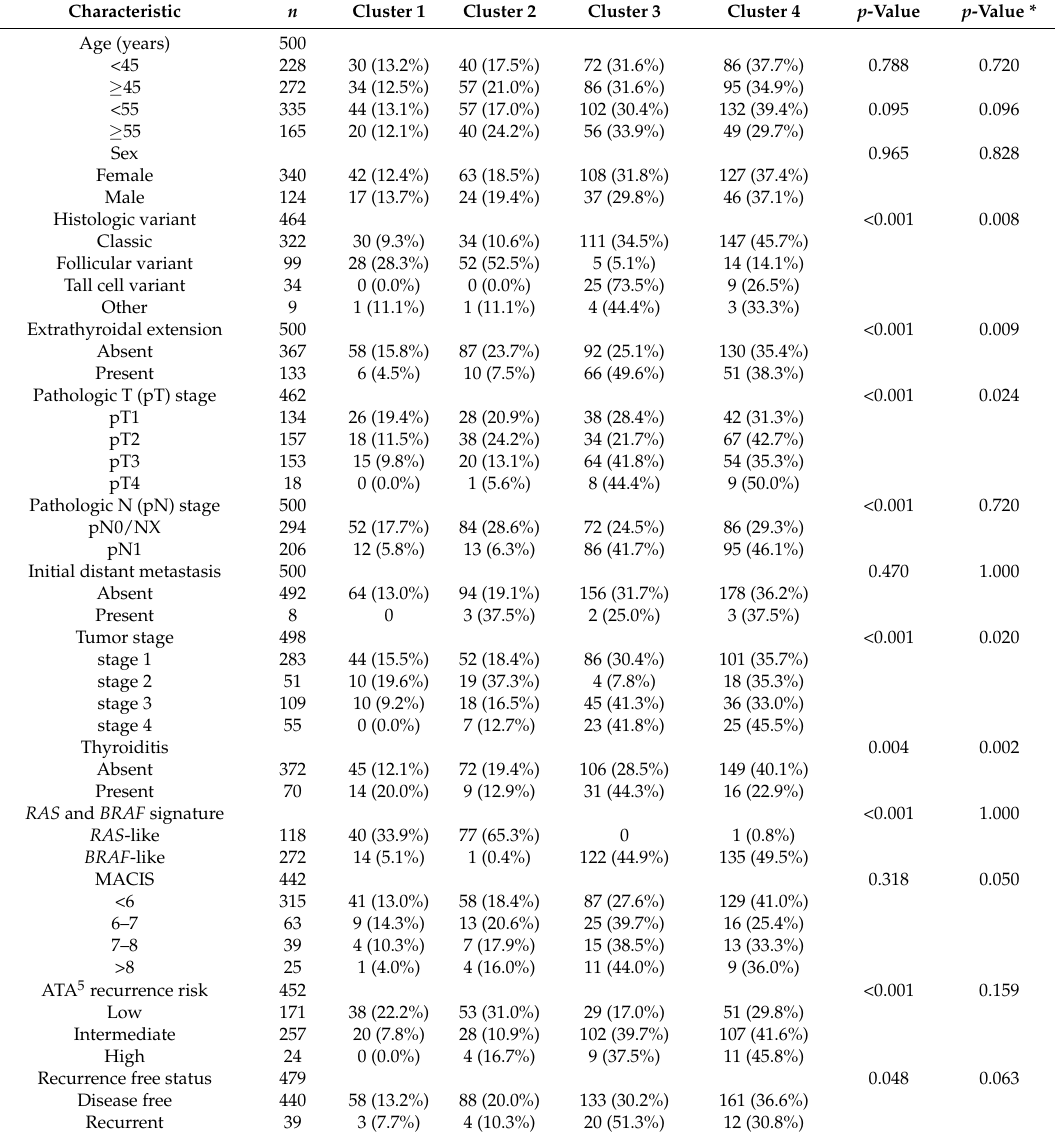
Table 1. Relationship between non-negative matrix factorization (NMF) clusters and clinicopathologic features of papillary thyroid carcinoma in TCGA dataset. Extrathyroidal extension includes minimal microscopic and gross invasion. Tumor stage was determined by the seventh edition of American Joint Cancer Committee cancer staging system. * p -value was analyzed between cluster three and cluster four. MACIS: Metastasis, patient Age, Completeness of resection, local Invasion, and tumor Size. ATA: American Thyroid